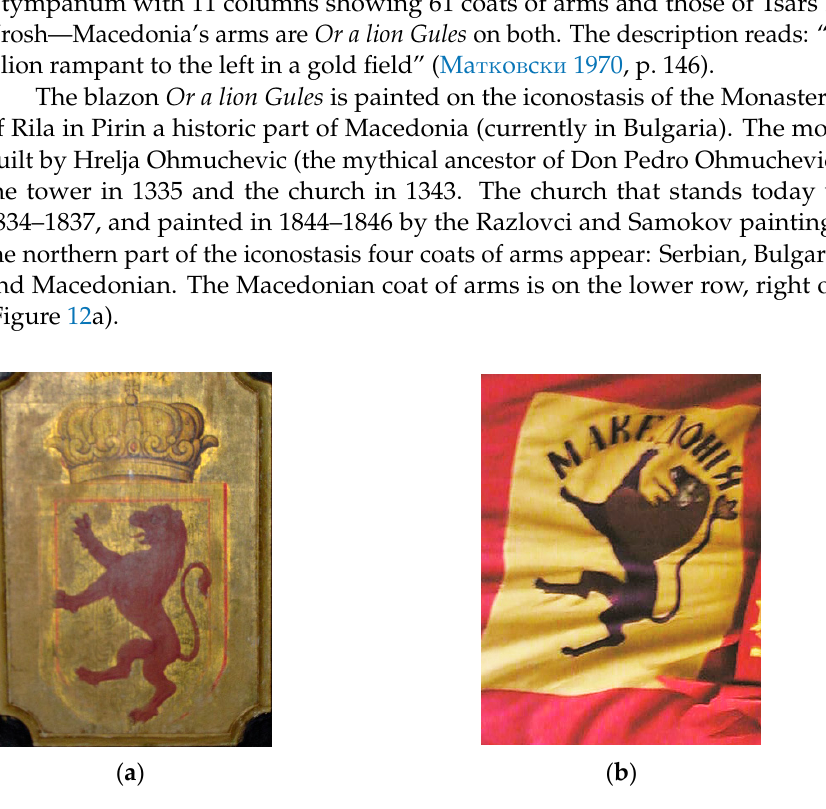
Figure 12. ( a ) Monastery of St. Ivan of Rila; ( b ) Flag of the Razlovci Uprising of